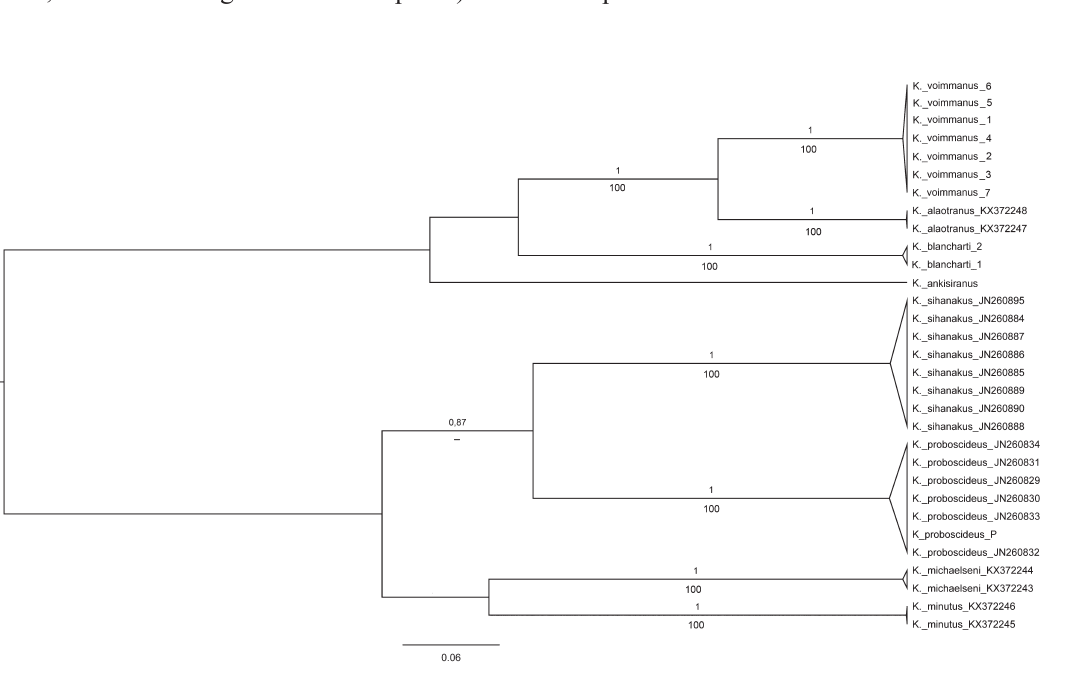
Fig. 5. Bayesian inference tree of some species of Kynotus Michaelsen, 1891 using COI sequences. Numbers above branches indicate Bayesian posterior probabilities, below branches ML bootstrap supports. Values lower than 80% are not